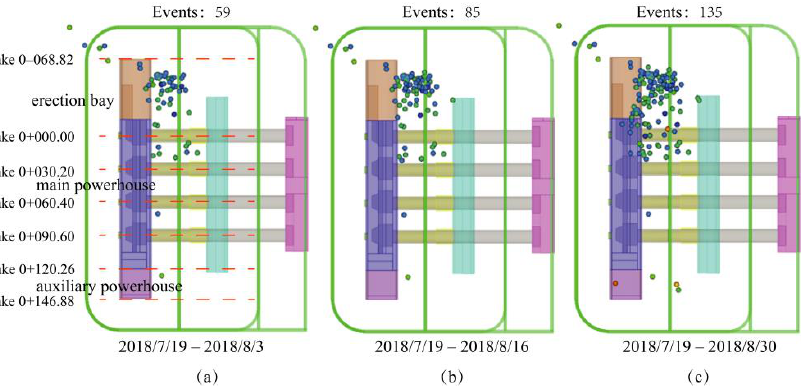
Figure 7. Spatial and temporal evolutions of the MS events from 19 July to 30 August 2018. ( a ), Spatial and temporal evolutions of the MS events from 19 July to 3 August 2018; ( b ), Spatial and temporal evolutions of the MS events from 19 July to 16 August 2018; ( c ), Spatial and temporal evolutions of the MS events from 19 July to 30 August 2018.